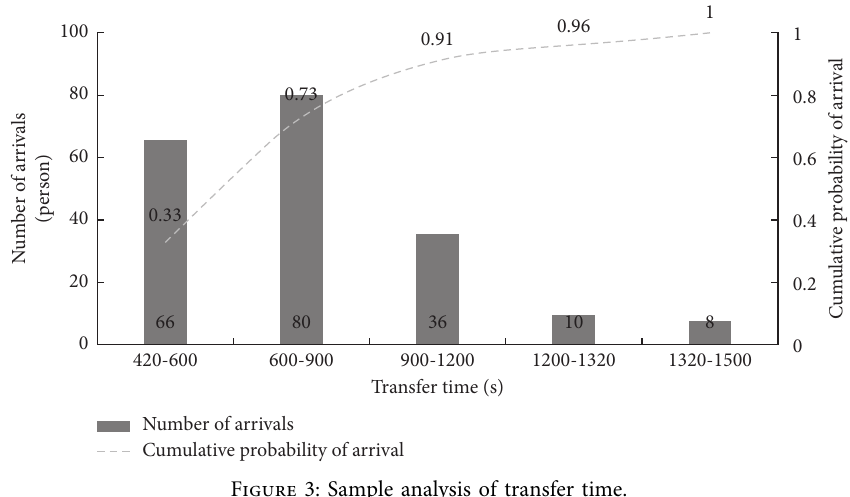
Figure 3: Sample analysis of transfer time.